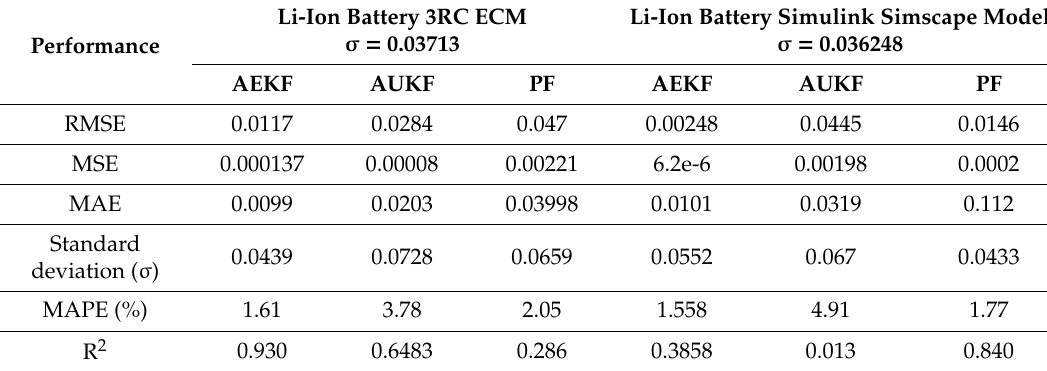
Table A2. Statistical errors—SOC estimates versus Li-ion battery Simscape model SOC values— Scenario R2: (SOCini = 1, Qnom = 4.2 Ah).